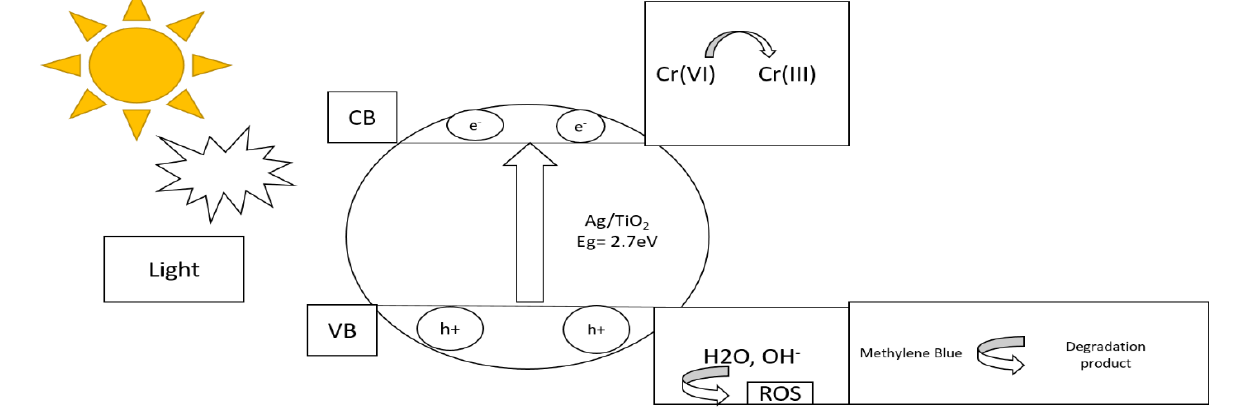
Figure 12. The simultaneous removal of photocatalytic pollutants by Ag/TiO 2 composite.